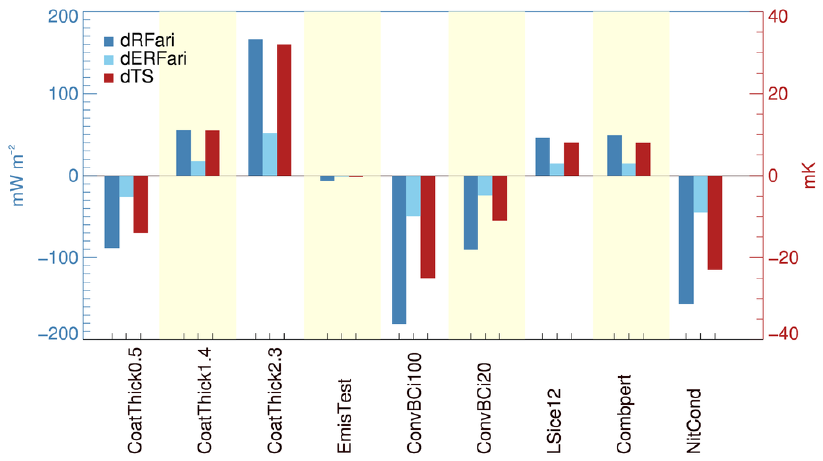
Figure 6. Net change in RFari, ERFari and TS between each sensitivity experiment and the base simulation, estimated using the kernels from (Samset and Myhre, 2015).